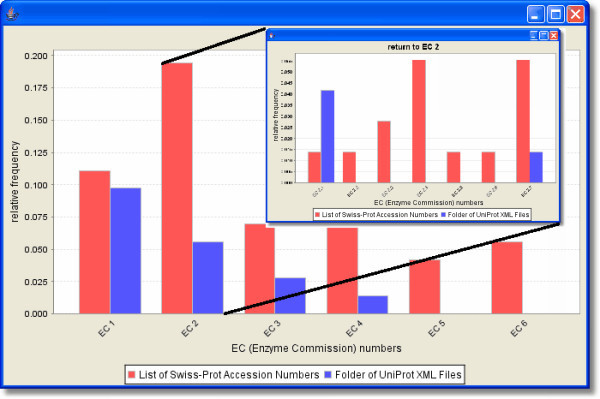
Example of an interactive browsable figure. Shown is a comparison of EC numbers found in the annotation of two protein sets. By clicking on the bars the user can zoom in and out the different levels of the Enzyme Nomenclature.